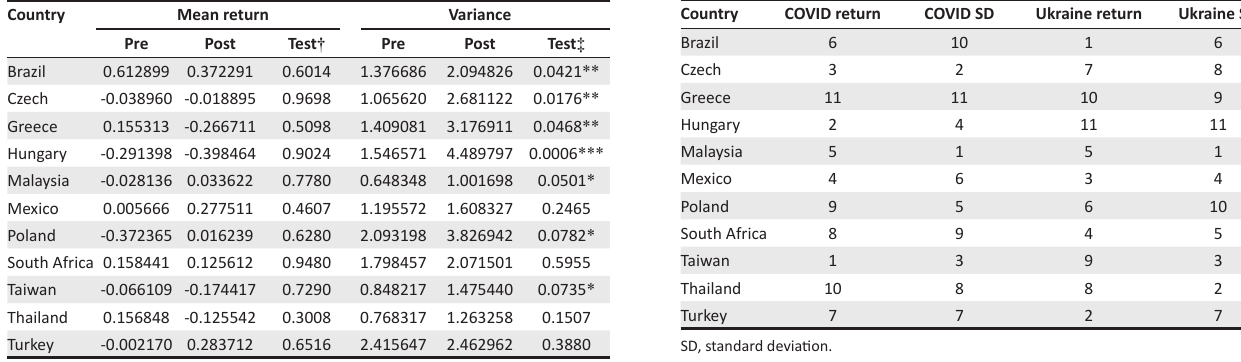
TABLE 6: Rankings according to performance after events.